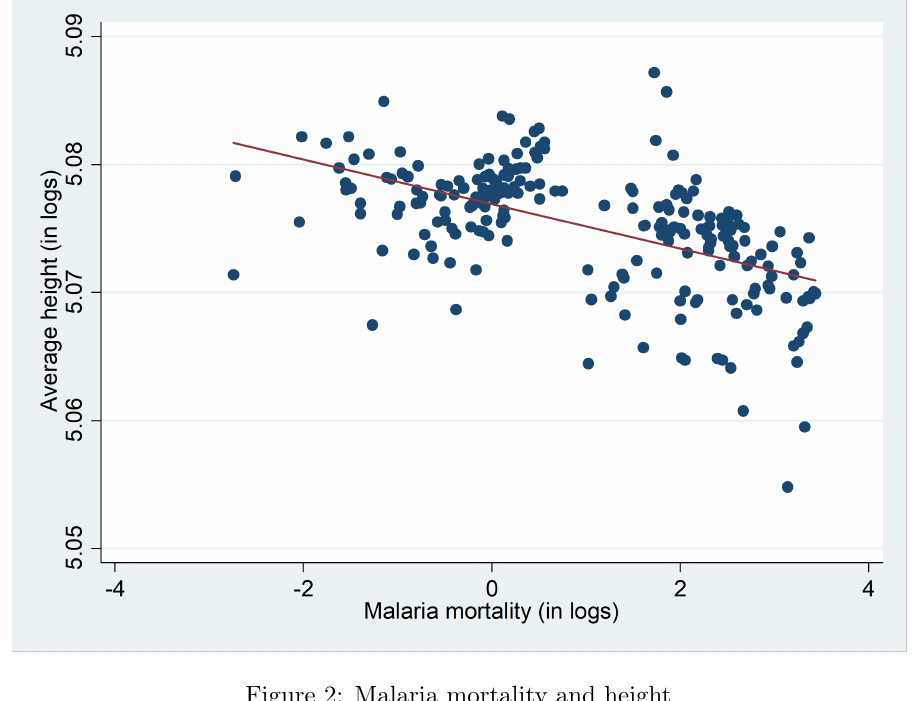
Figure 2: Malaria mortality and height Table 3: Average height of conscripts Regions with high Regions with low malaria